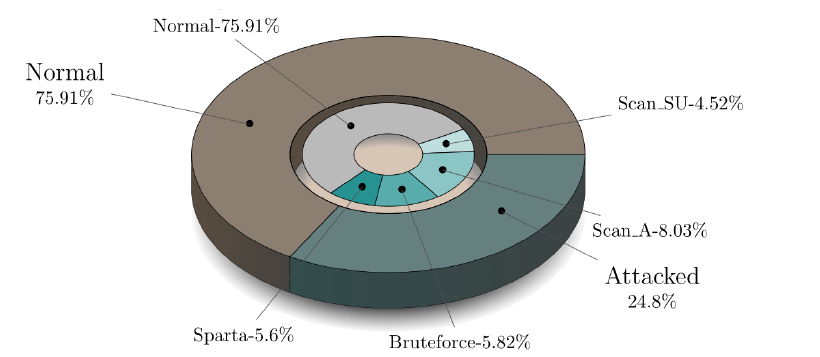
Figure 5. MQTT-IoT-IDS2020 pre-processing.